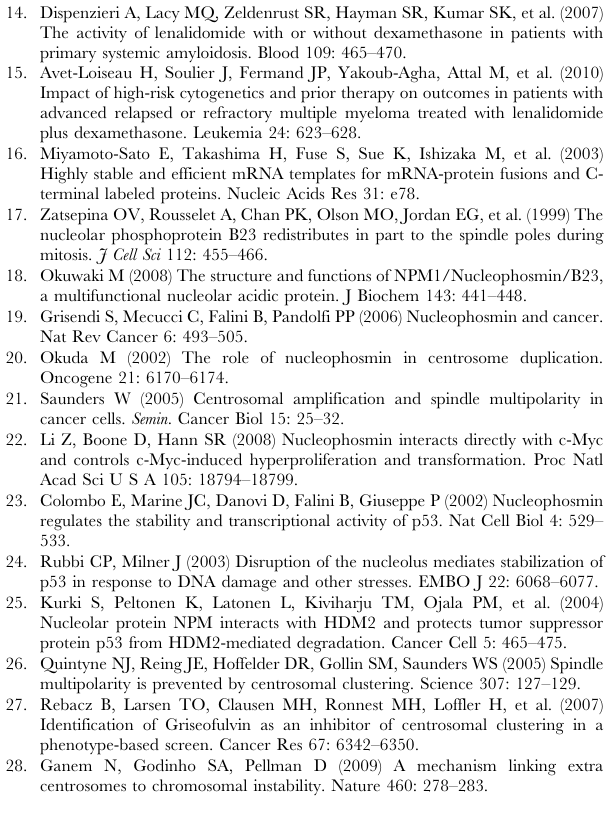
Figure S3 TC11 or LMB does not affect localization of NPM on centrosome. (A) HeLa cells were treated with 5 m M TC11 or 100 nM LMB for 6 h. Then, immunofluorescence staining of NPM (green) or c -tubulin (red) was performed. Representative mitotic cells under the indicated conditions are shown. White arrowheads and arrows indicate NPM and centrosomes, respectively. White arrow indicates centrosome. Bar; 10 m m. (TIF) Figure S4 Thalidomide does not induce multipolarity of mitotic cells. HeLa cells were treated with 10 or 20 m M thalidomide for 6 h. Then, immunofluorescence staining of c - tubulin was performed. At least 50 mitotic cells were counted in three independent experiments. The ratio of cells with multipolar spindles under the indicated conditions was quantified.